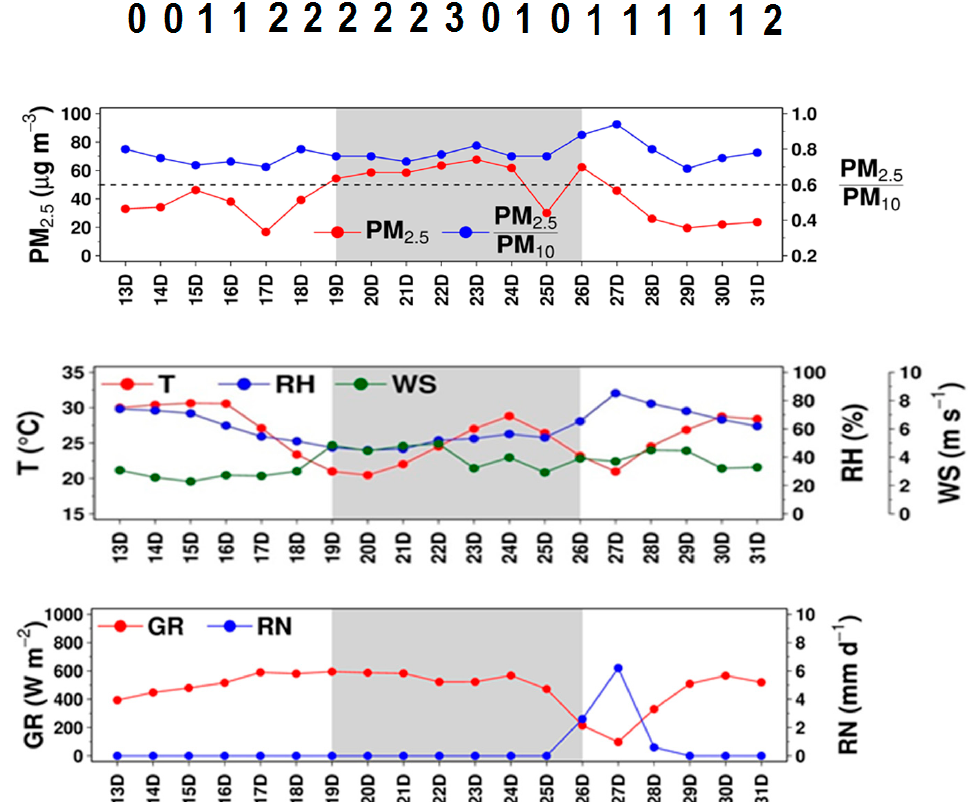
Figure 6. Daily PM 2.5 , PM 2.5 / PM 10 , and other meteorological variables during EP2.